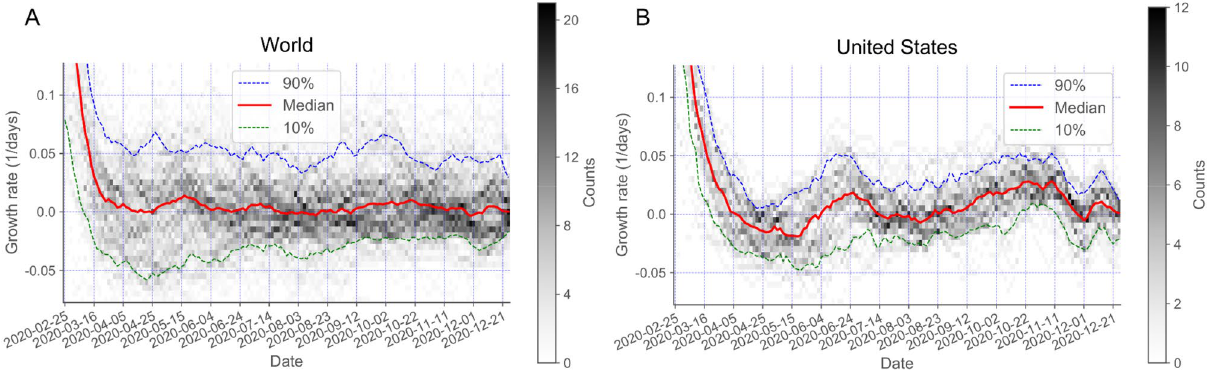
Figure 5. The temporal evolution of the distribution of growth rates shows a double stabilization of the outbreak. The temporal evolution of the median (red line), first decile (green line), and tenth decile (blue line) of the growth rates are plotted over the gray-coded histogram for countries in the world ( A ) and states and territories of the US ( B ). The median converges towards zero values and the deciles move closer to each other in a fluctuating manner for countries in the World and locations in the US. The double stabilization means that growth rates have mainly moved towards zero values both at local scales and at a global scale. At local scales, growth rates for most countries and states, whether positive or negative, decreased in absolute value, leading to a slowdown of the dynamics. At World and US global scales, positive and negative values for each of the locations have converged towards statistically compensating each other, decreasing further the overall net growth of the infectious